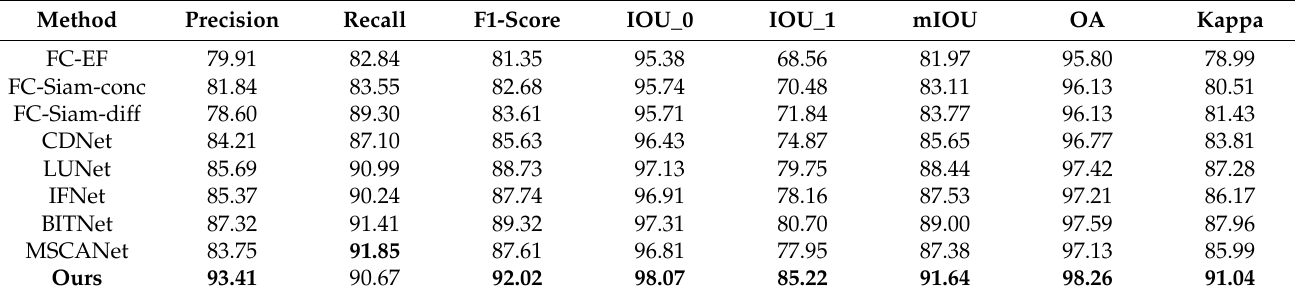
Table 3. Quantitative comparisons of various CD methods from the LEVIR-CD